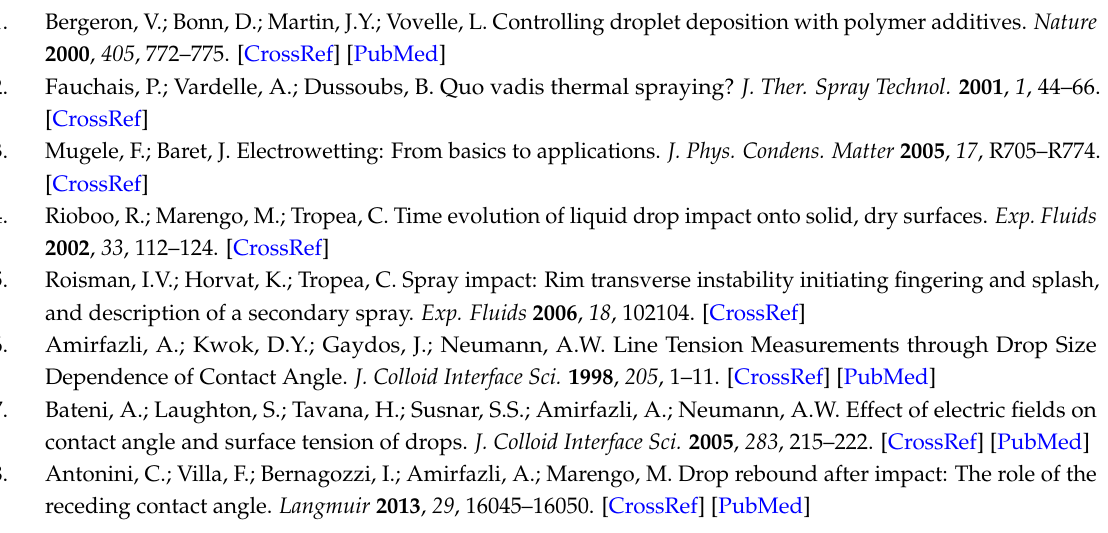
Figure 11. Variation in ξ max versus θ e